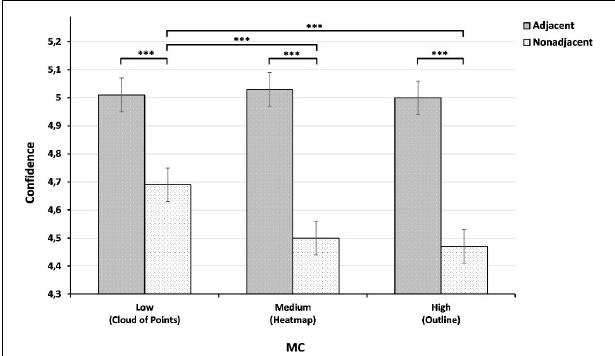
FIGURE 5 | Comparison of adjacent and non-adjacent visualizations based on their MC from low to high. ∗∗∗ p <